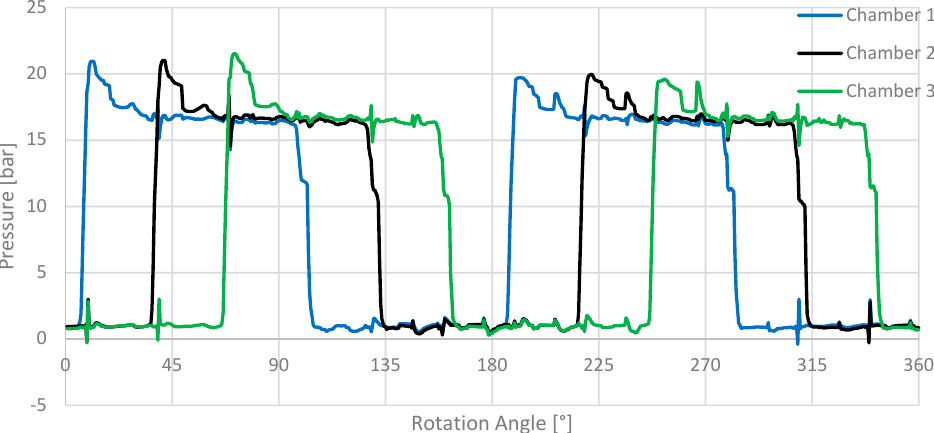
Figure 17. Predicted pressure signal of three succeeding displacement chambers for a delivery pressure of 15 bar and a rotational speed of 2000 rpm.